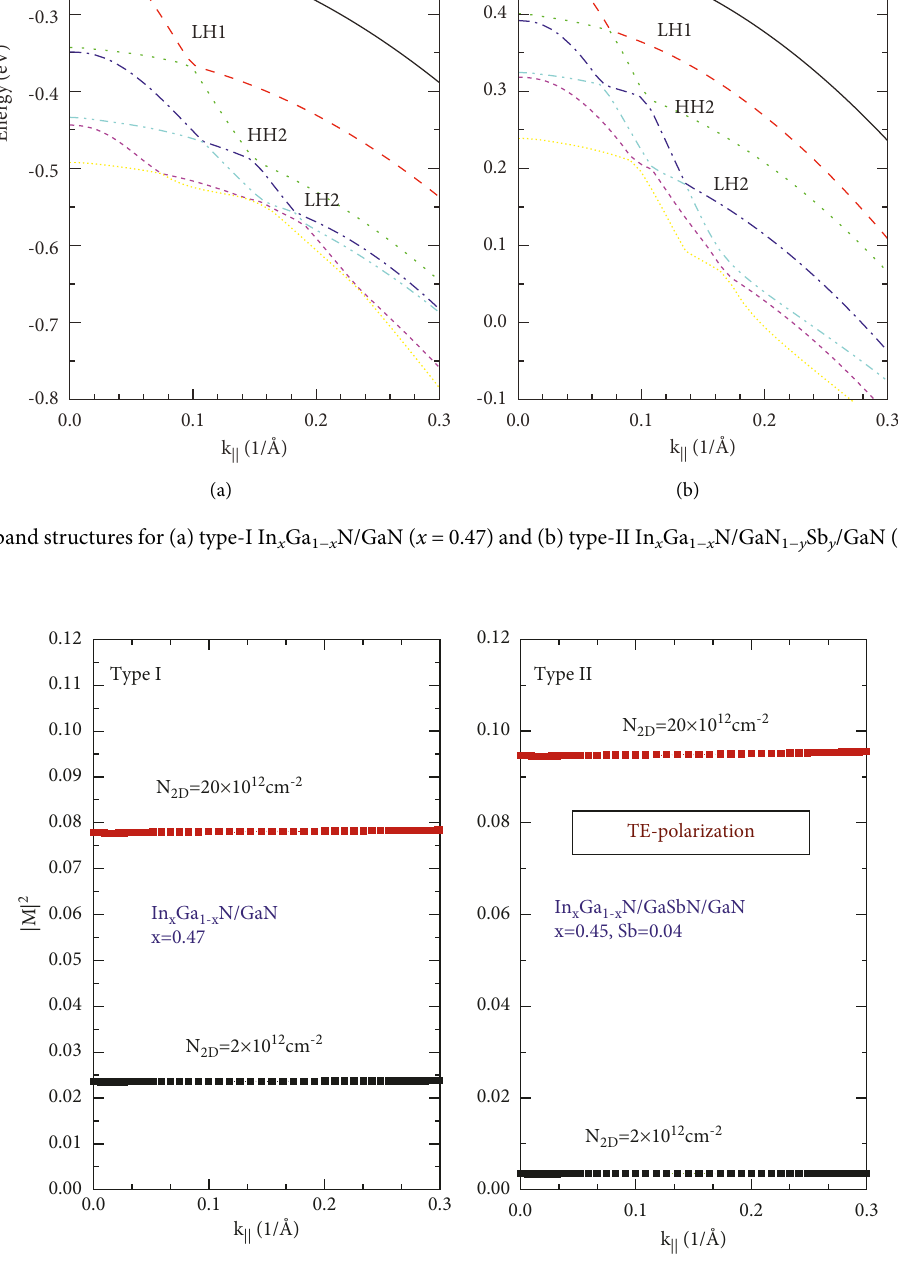
Figure 3: TE-polarized optical matrix elements for (a) type-I In x Ga 1 − x N/GaN ( x = 0.47) and (b) type-II In x Ga 1 − x N/GaN 1 − y Sb y /GaN ( x � 0 . 45, y � 0 . 04) QW structures as a function of k ‖ at sheet carrier densities of 1 × and 20 × 10 12 cm − 2